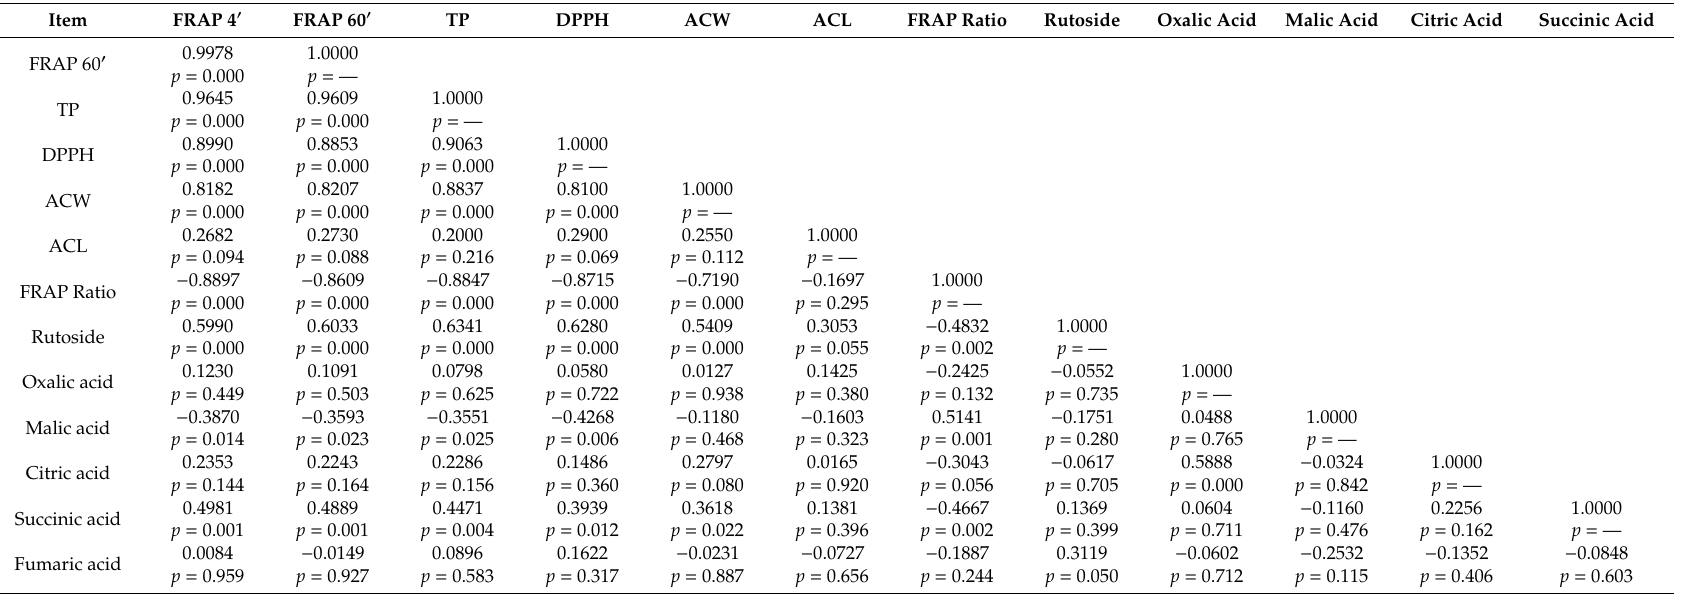
Table 3. Correlation coe ffi cients and their levels of significance ( p